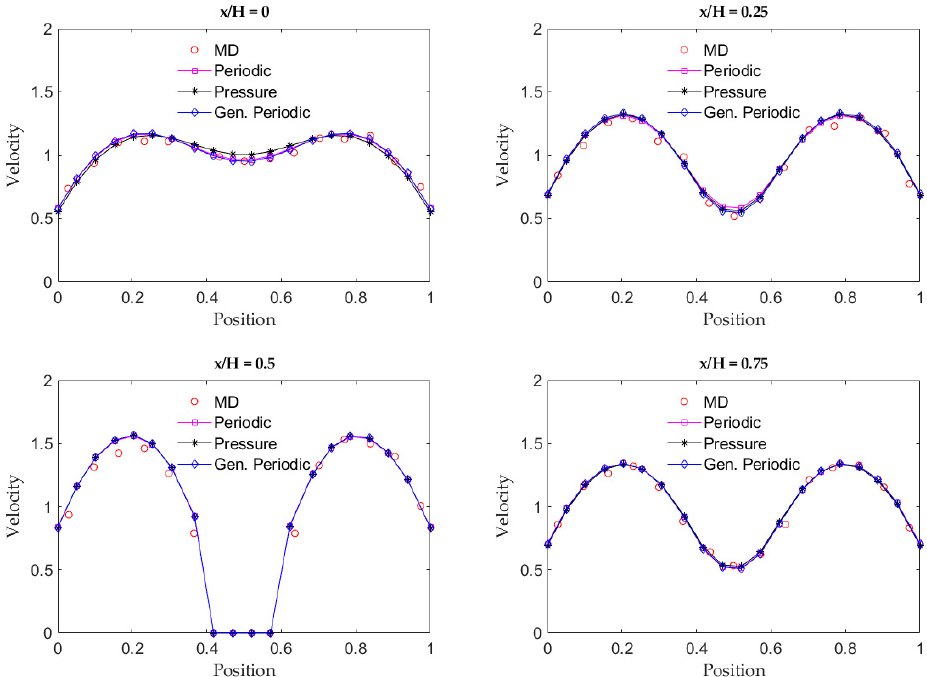
Figure 8. Velocity profiles using three inlet–outlet treatments at different cross sections. Y axes represent normalized streamwise velocity, and X axes represents the position across the channel.